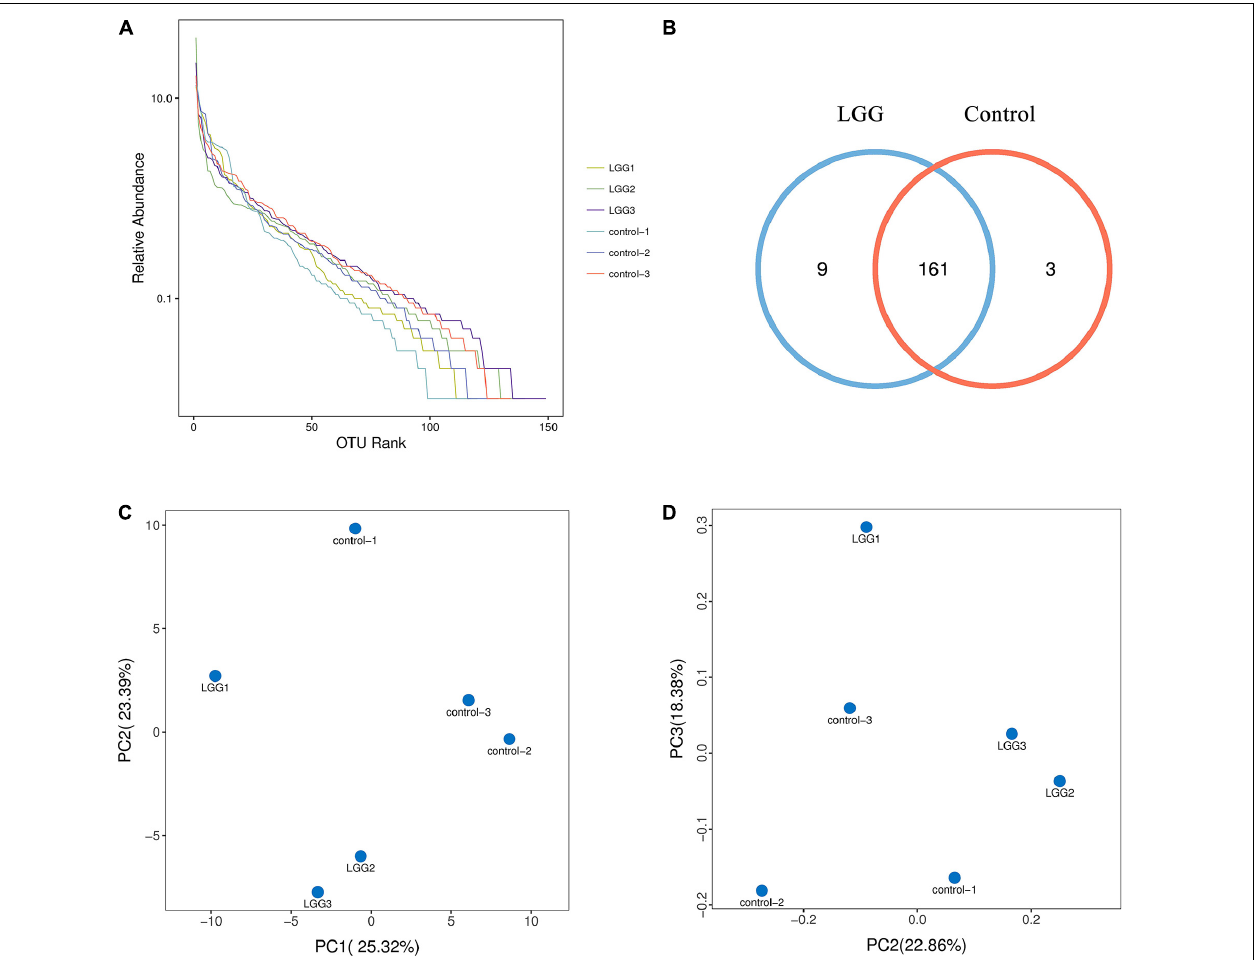
FIGURE 3 | Effects of dietary LGG on cecal microbial diversity in chickens. The cecal contents of chickens fed with LGG and the controls were collected for high-throughput sequence analysis after 21 days of feeding. (A) α -diversity of OTU rank abundance. (B) OTU Venn diagram between the LGG group and the control group. (C) Principal component analysis (PCA) plot based on the distribution of bacterial community. (D) Principal coordinates analysis (PCoA) plot using Brary–Curtis distances. The percentage represents the contribution of the principal component to the sample